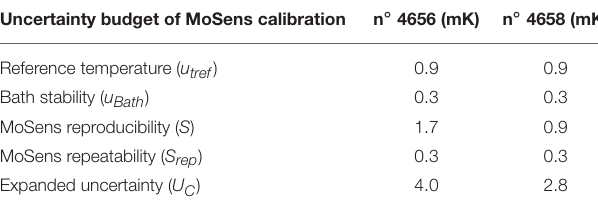
TABLE 2 | Calibration uncertainty budget of the two MoSens prototypes.